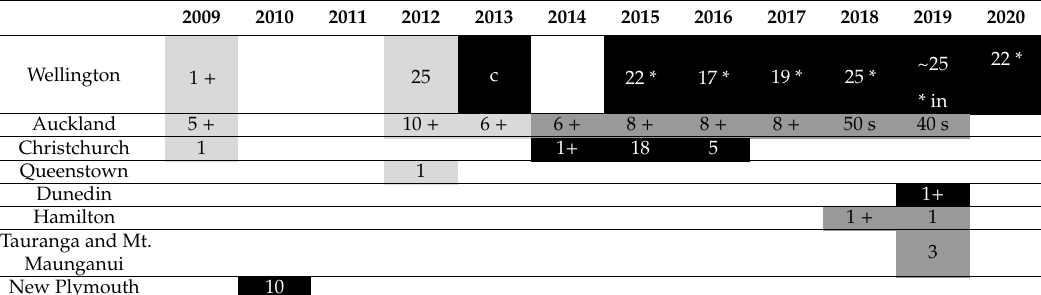
Table 3. City council involvement (black—city council financial support; dark grey—cc agreement / permission; light grey—independent—no support) and the amount of parking spaces taken over during PD (numbers). Additional key: + —number equal or larger; ~—estimated number; c—event cancelled due to bad weather; in—event partially indoors due to bad weather; *—event moved to March; s—several locations including